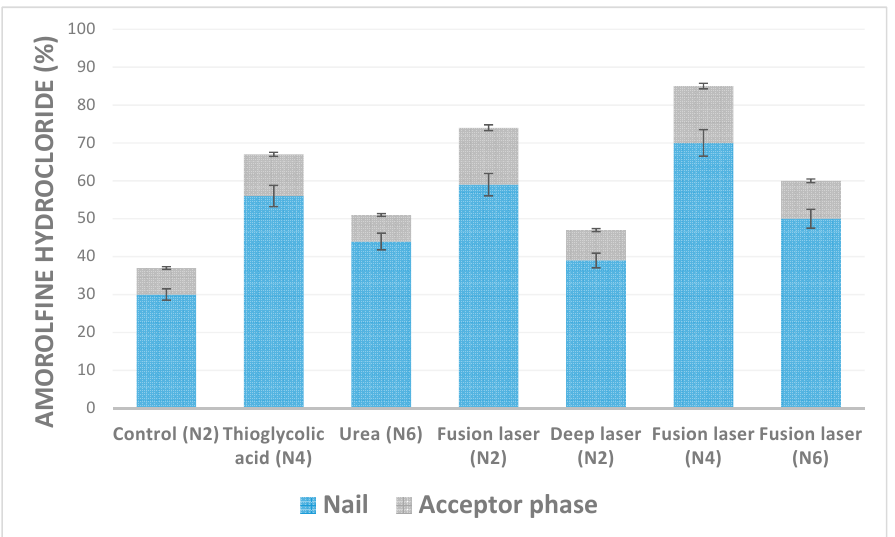
Figure 2. Chemical and physical enhancement of penetration of amorolfine hydrochloride after application nail lacquers (n = 2).